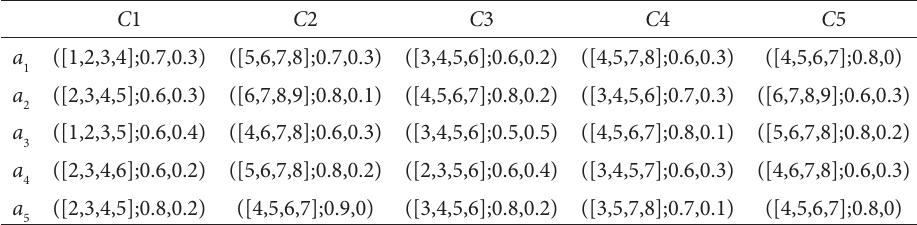
Table 1. Criteria values for all alternatives C 1 C 2 C 3 C 4 C 5